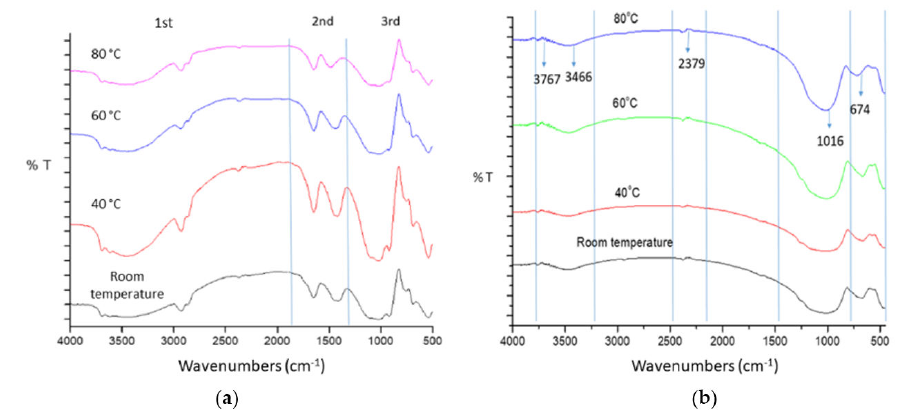
Figure 6. FTIR spectrum of the ( a ) as-cured kaolin-GGBS geopolymer and ( b ) sintered kaolin-GGBS